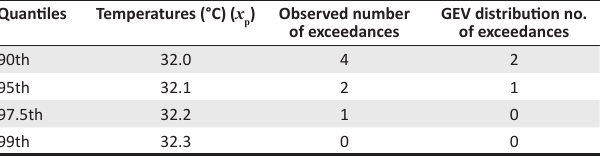
) Observed number GEV distribution no. p of exceedances of exceedances